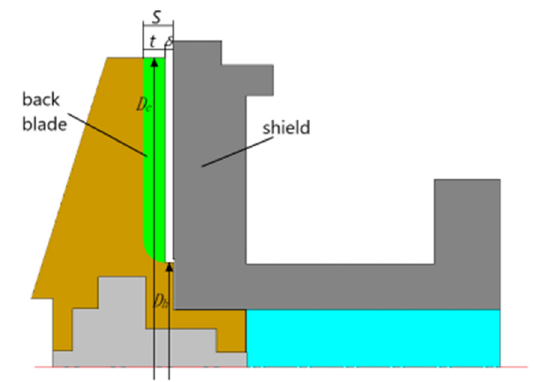
Figure 1. Structure diagram of the back blade seal.